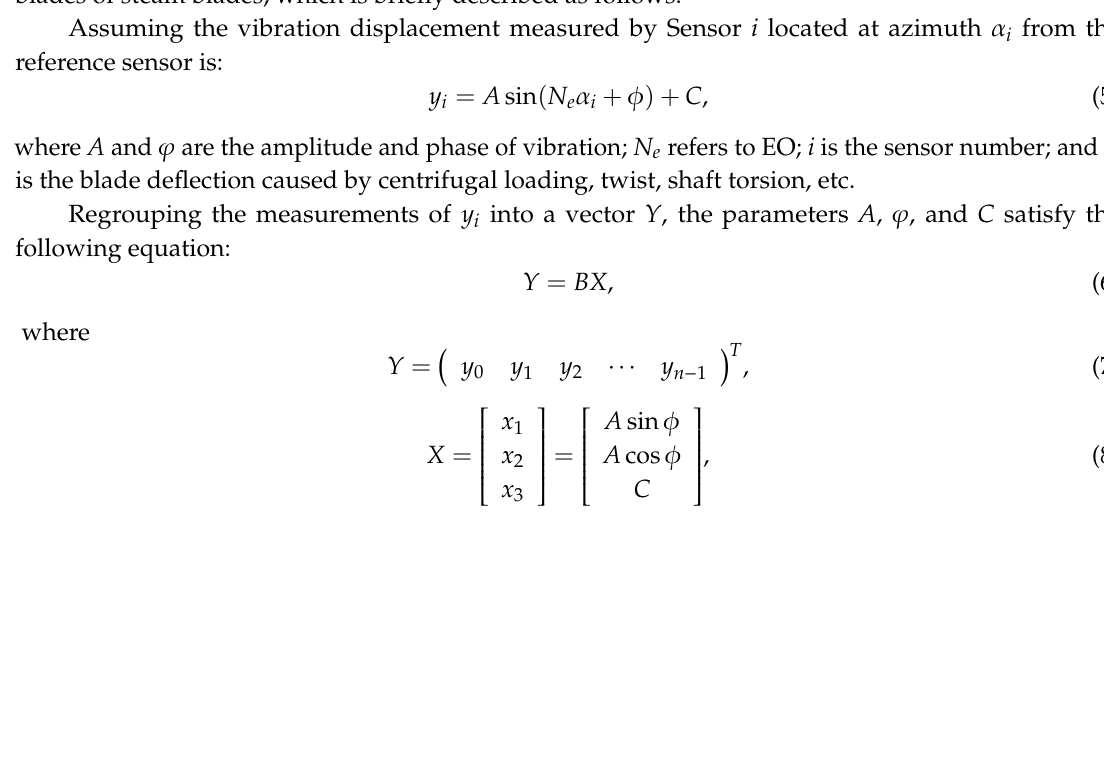
Figure 5. Results of the sensor’s performance.